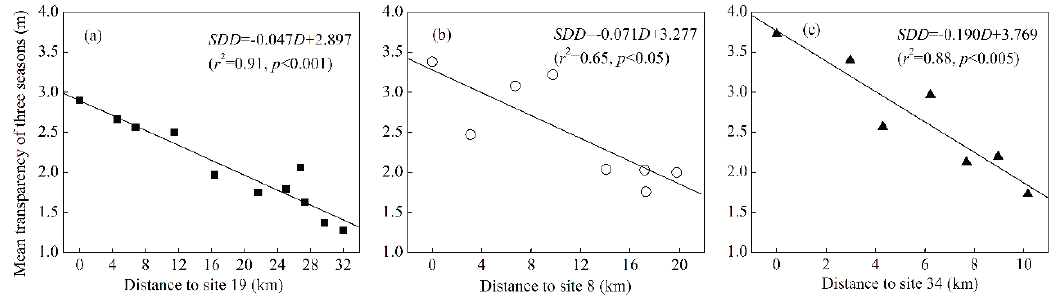
Figure 3. Linear relationships between the mean transparency of three seasons from 2013 to 2014 and the distance to site 19 for the Xin’anjiang River (sites 9–19) ( a ), to site 8 for the Fuqiangxi River (sites 1–8) ( b ), and to site 34 for the Wuqiangxi River (sites 28–34) ( c